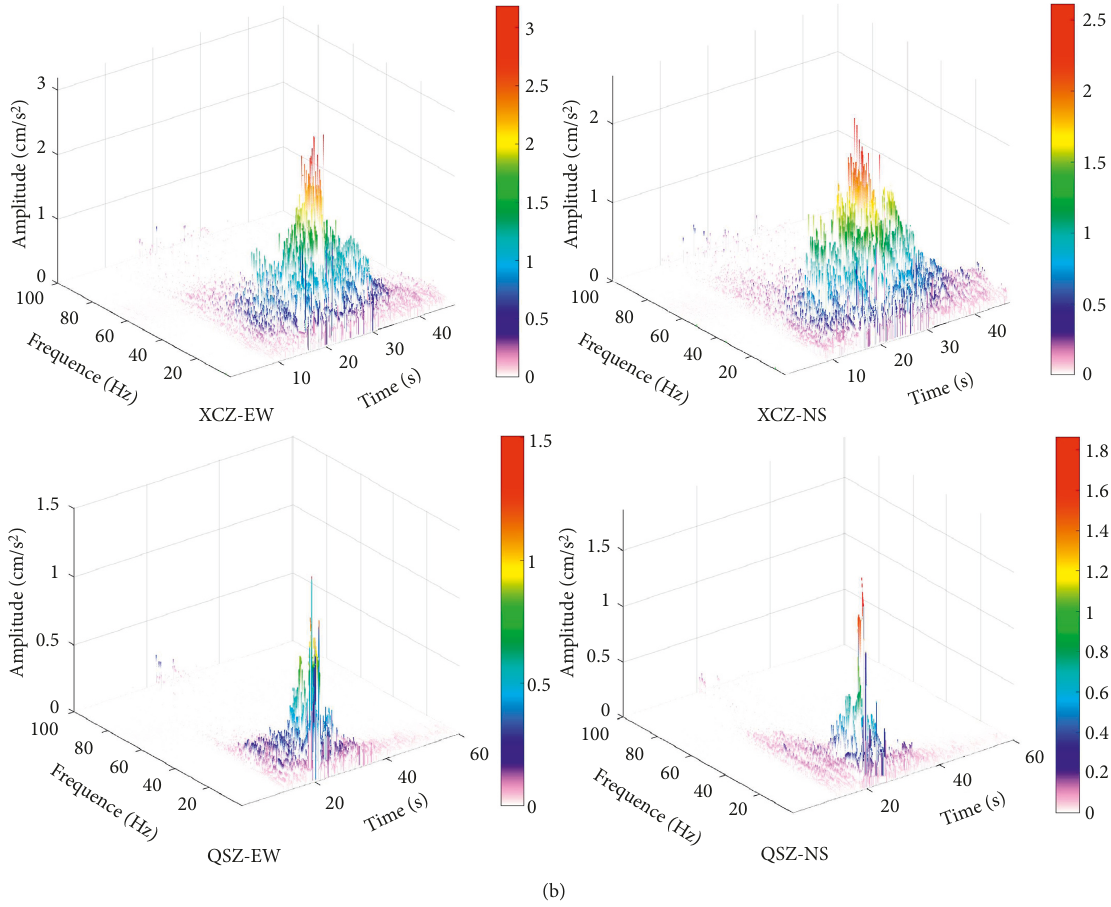
Figure 5: Hilbert-Huang spectrum of the reconstructed signal of HJA, YCH, XCZ, and QSZ.